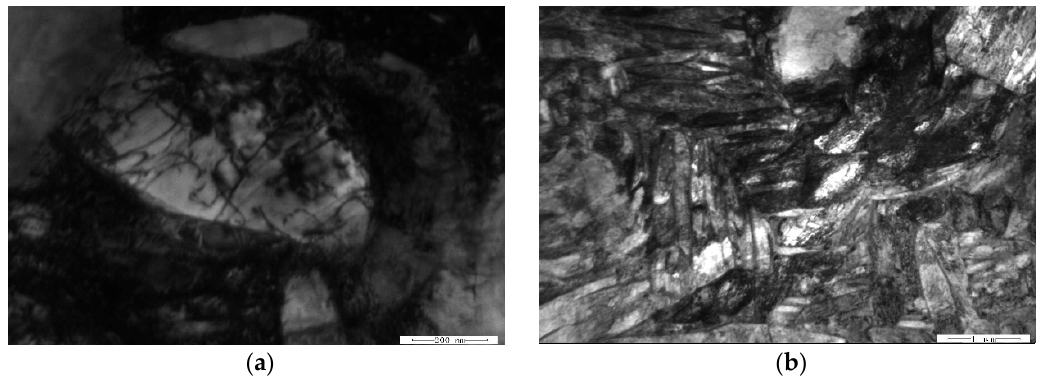
Figure 10. TEM images of creep sample HT-760 at 650°C/150MPa, ( a ) α 2 particles, ( b ) lamellar O phase.